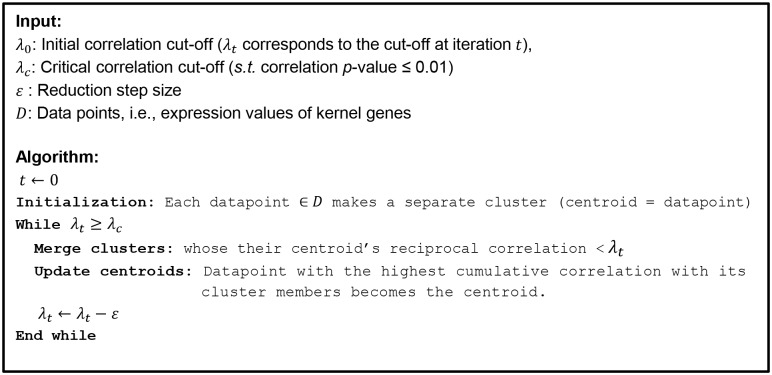
Clustering component for Application II.The proposed clustering algorithm used to identify prevalent TG expression patterns and singletons within the kernel set.